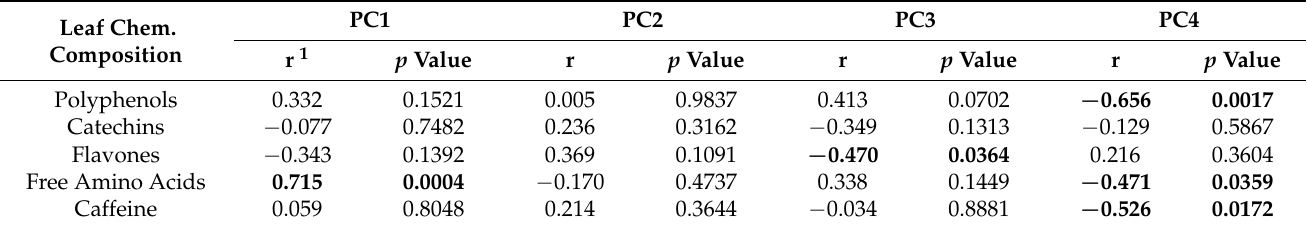
Table 6. PCA correlations between PCA score of average soil properties at 0–60 cm depth and chemical composition in Sijichun